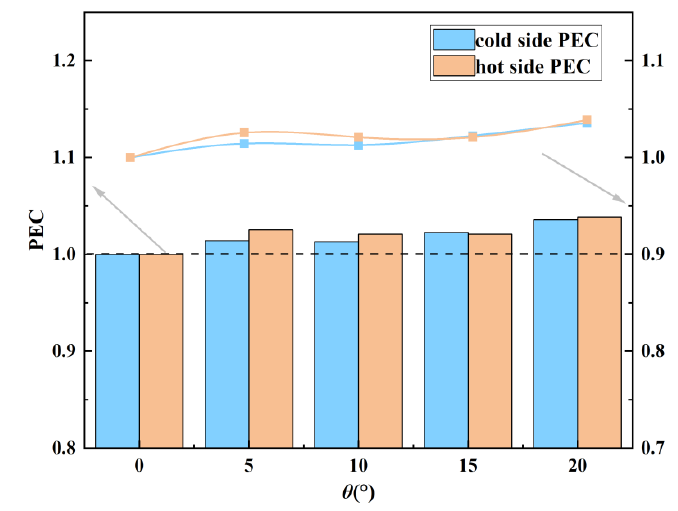
Figure 14. Relation between PEC and angle θ of spiral structure.